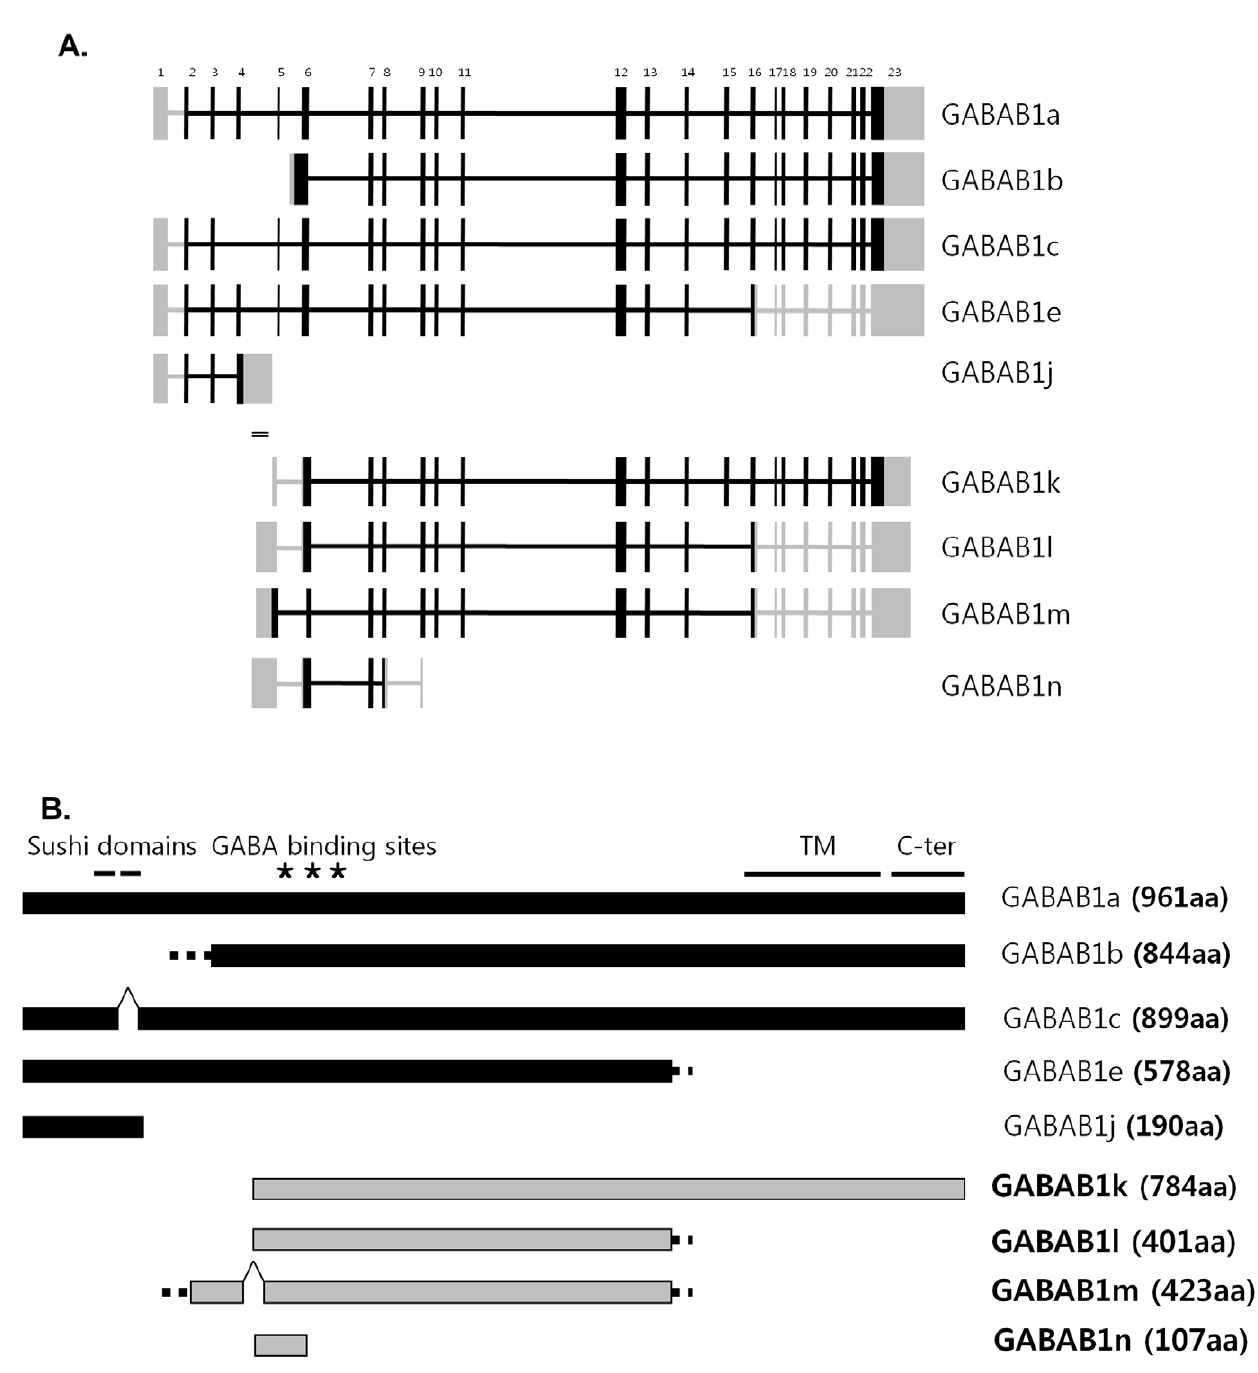
Figure 1. Schematic summary of GABAB1 isoforms. A. Introns and exons of known and novel GABAB1 isoforms were compared. The numbers listed at the top are exon numbers of GABAB1a. Blocks represent exons, and lines are introns of the GABAB1 gene. Black lines and blocks are ORFs, and grey lines and blocks are UTRs. Double line is cDNA microarray probe, clone 300899, which aligns to the intron 4 of GABAB1a. Human GABAB1a, b, c, e, and rat GABAB1j are previously identified isoforms. After cloning, the following novel isoforms were found in human: GABAB1k, GABAB1l, GABAB1m, and GABAB1n. Human GABAB1j was predicted. Mouse GABAB1j and GABAB1k were also cloned. GABAB1k contains the 3 9 part of intron 4 through exon 23. GABAB1l has additional splicing out of exon 15, and GABAB1m has similar splicing patterns as GABAB1l except for additional splicing out at 5 9 part of exon 6. GABAB1n has an SNP on exon 8. B. ORFs of GABAB1 isoforms are shown with important functional domains. Black bars are previously known isoforms, and grey bars represent novel isoforms. Dotted lines stand for unique sequence of each isoform. GABAB1k contains GABA binding sites, seven transmembrane domains, a G-protein coupling region, and a C-terminal intracellular region. GABAB1l and GABAB1m do not have transmembrane domains, a G-protein coupling region, or C-terminal intracellular regions (same as GABAB1e). GABAB1m has a longer N-terminal than GABAB1l. GABAB1n contains only a partial GABA binding site.